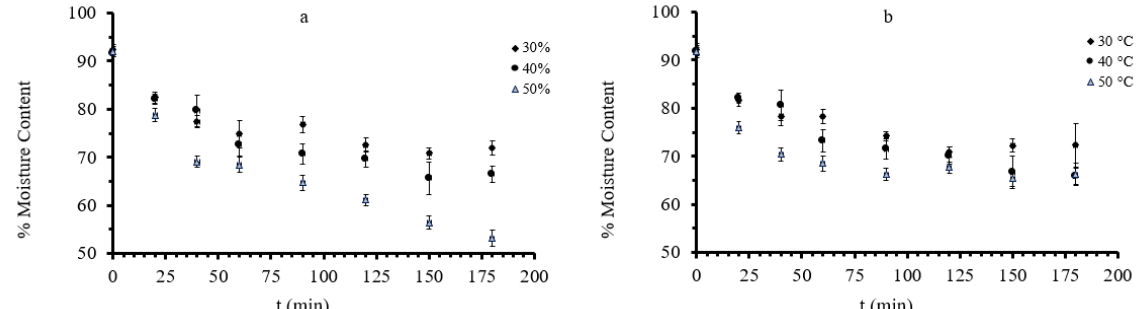
Figure 4. ( a ): %MC (moisture content on a wet basis) during osmotic dehydration at 40 °C, at all three different glycerol concentration and ( b ) %MC during osmotic dehydration at 40% glycerol concentration, at all three different temperatures. Points represent average values, and error bars represent the standard deviation, as calculated from the three measurements.